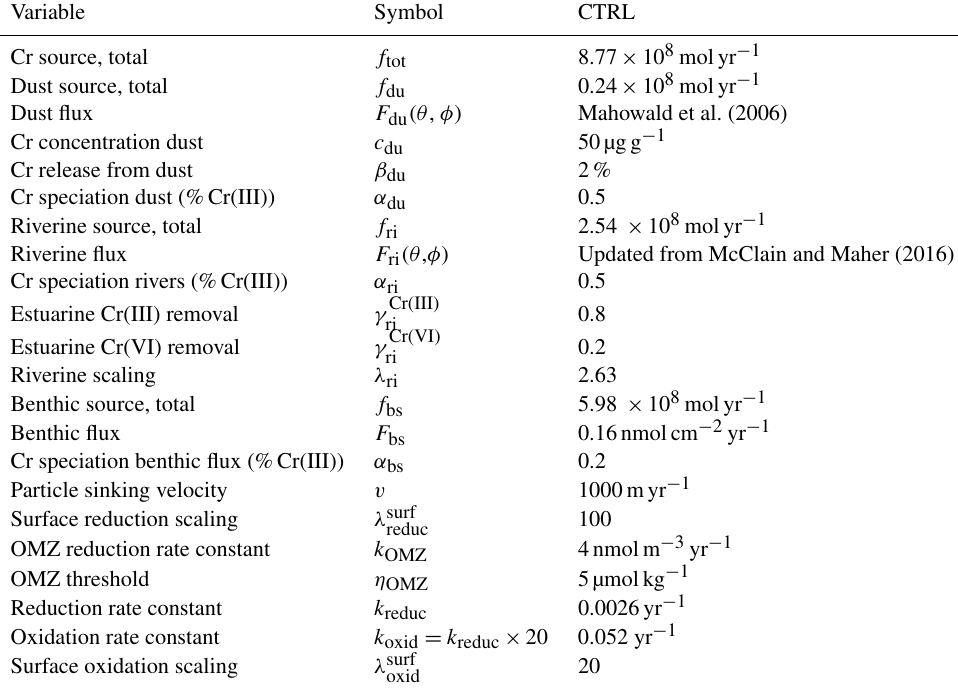
Table 1. Model parameters and their values for the control run (CTRL). The rationale inherent to the input parameters is discussed in the